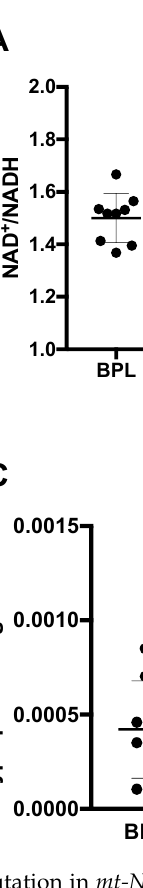
Figure 3. The mutation in mt-Nd2 is associated with alteration of tryptophan levels. ( A ) A ratio of NAD + to NADH was measured in liver tissues of young (3 months old) female B6-mt BPL and B6-mt ALR mice. No difference was observed (descriptive p = 0.3737, t- test). n = 9/strain. BPL: B6-mt BPL ; ALR: B6-mt ALR . ( B ) A region of the NMR spectra of a well-separated signal of tryptophan in B6-mt ALR fibroblast cell line (red) and B6-mt BPL fibroblast cell line (black) is displayed. n = 5 (B6-mt ALR cell lines), n = 7 (B6-mt BPL cell lines). ( C ) Tryptophan levels identified in panel B were quantified and compared between the groups. The mean value of the two signals was compared. Descriptive p = 0.0295, t -test.